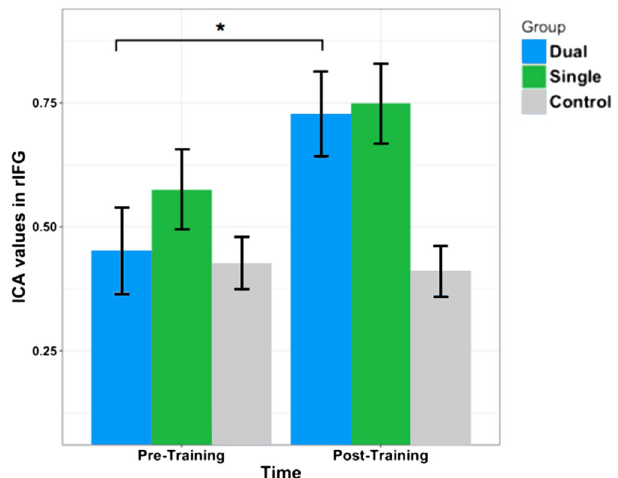
Figure 4. Bar plot illustrating the time × group interaction in the rIFG cluster depicted in dark blue in Fig. 3, for each group separately: dual training group (blue), single training group (green) and control group